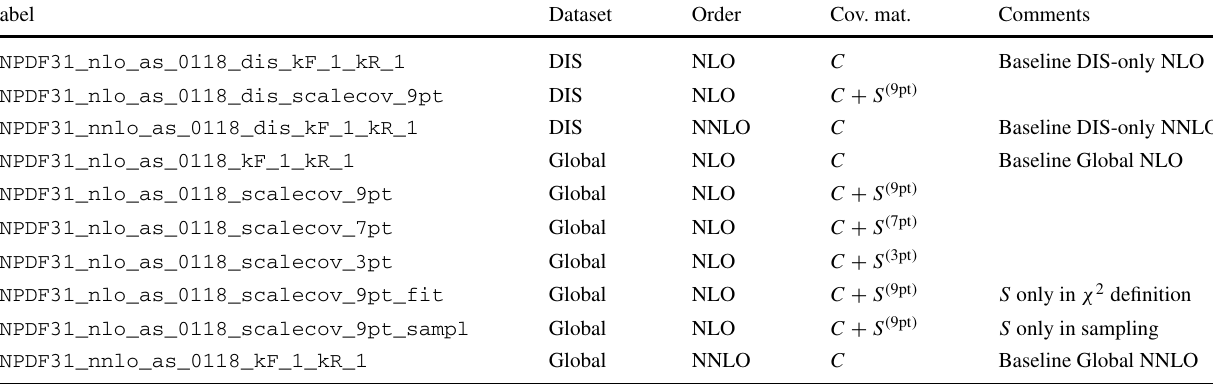
Table 5 Summary of the PDF sets discussed in this section. The dataset, perturbative order and nature of the treatment of uncertainties for each set are indicated